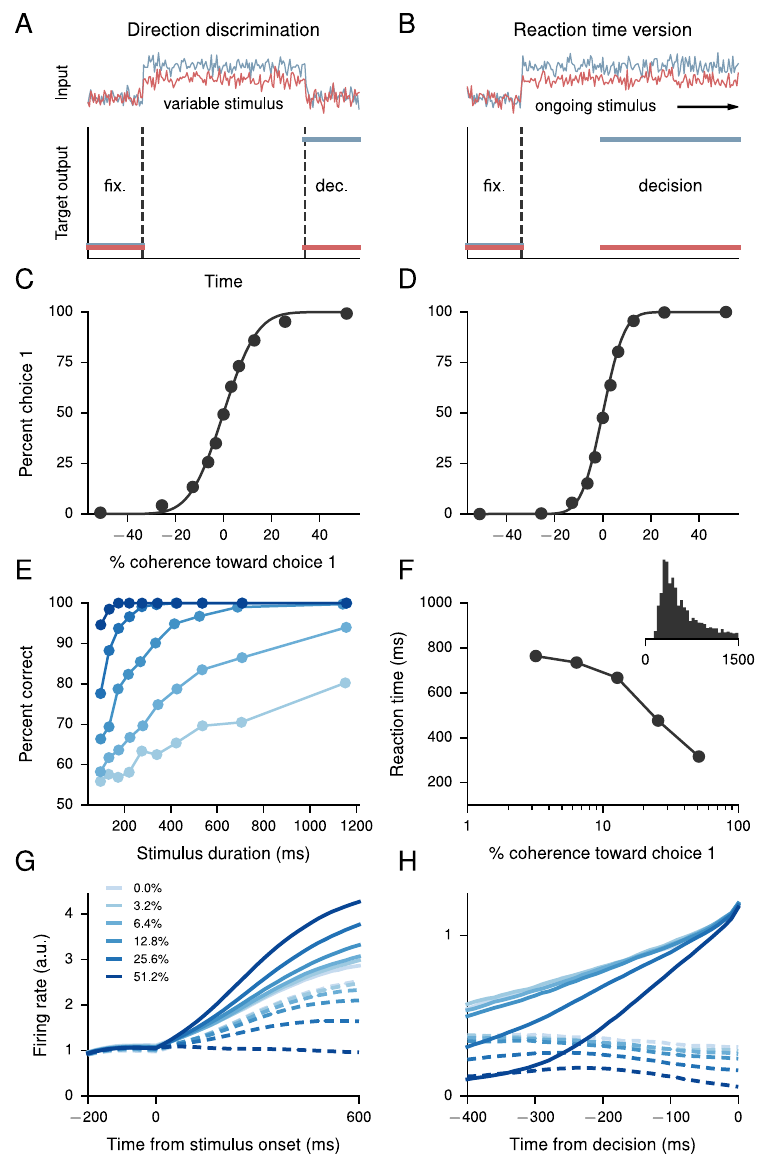
Fig 2. Perceptual decision-making task. (A) Inputs (upper) and target outputs (lower) for a perceptual decision-making task with variable stimulus duration, which we refer to as VS here. The choice 1 output must hold low during fixation (fix.), then high during the decision (dec.) period if the choice 1 input is larger than choice 2 input, low otherwise, and similarly for the choice 2 output. There are no constraints on output during the stimulus period. (B) Inputs and target outputs for the reaction-time version of the integration task, which we refer to as RT. Here the outputs are encouraged to respond after a short delay following the onset of stimulus. The reaction time is defined as the time it takes for the outputs to reach a threshold. (C) Psychometric function for the VS version, showing the percentage of trials on which the network chose choice 1 as a function of the signed coherence. Coherence is a measure of the difference between evidence for choice 1 and evidence for choice 2, and positive coherence indicates evidence for choice 1 and negative for choice 2. Solid line is a fit to a cumulative Gaussian distribution. (D) Psychometric function for the RT version. (E) Percentage of correct responses as a function of stimulus duration in the VS version, for each nonzero coherence level. (F) Reaction time for correct trials in the RT version as a function of coherence. Inset: Distribution of reaction times on correct trials. (G) Example activity of a single unit in the VS version across all correct trials, averaged within conditions after aligning to the onset of the stimulus. Solid (dashed) lines denote positive (negative) coherence. (H) Example activity of a single unit in the RT version, averaged within conditions and across all correct trials aligned to the reaction